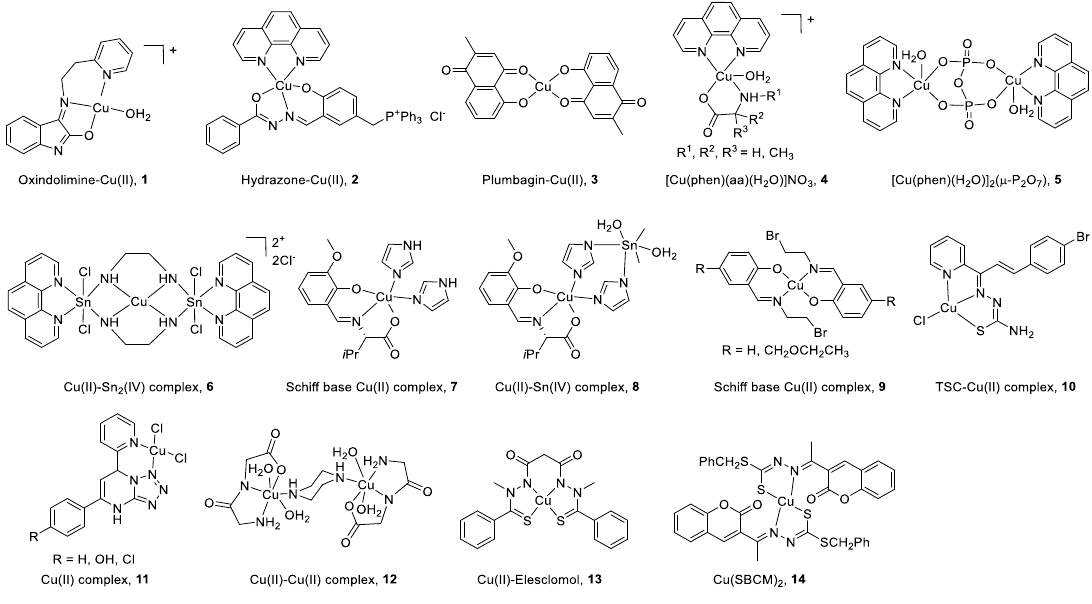
Figure 2. Structure of Cu(II) complexes as Top1 inhibitors.